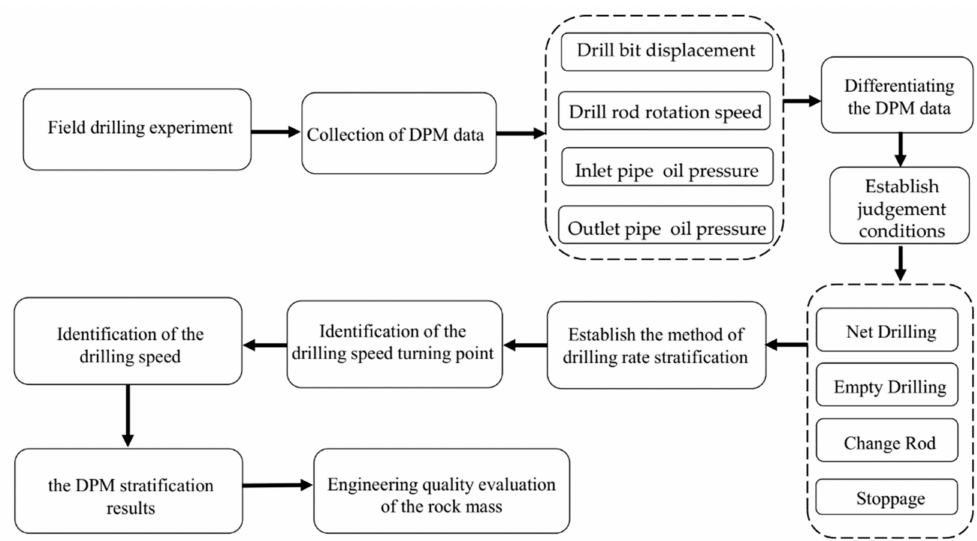
Figure 2. Flowchart of the DPM cataloguing method.